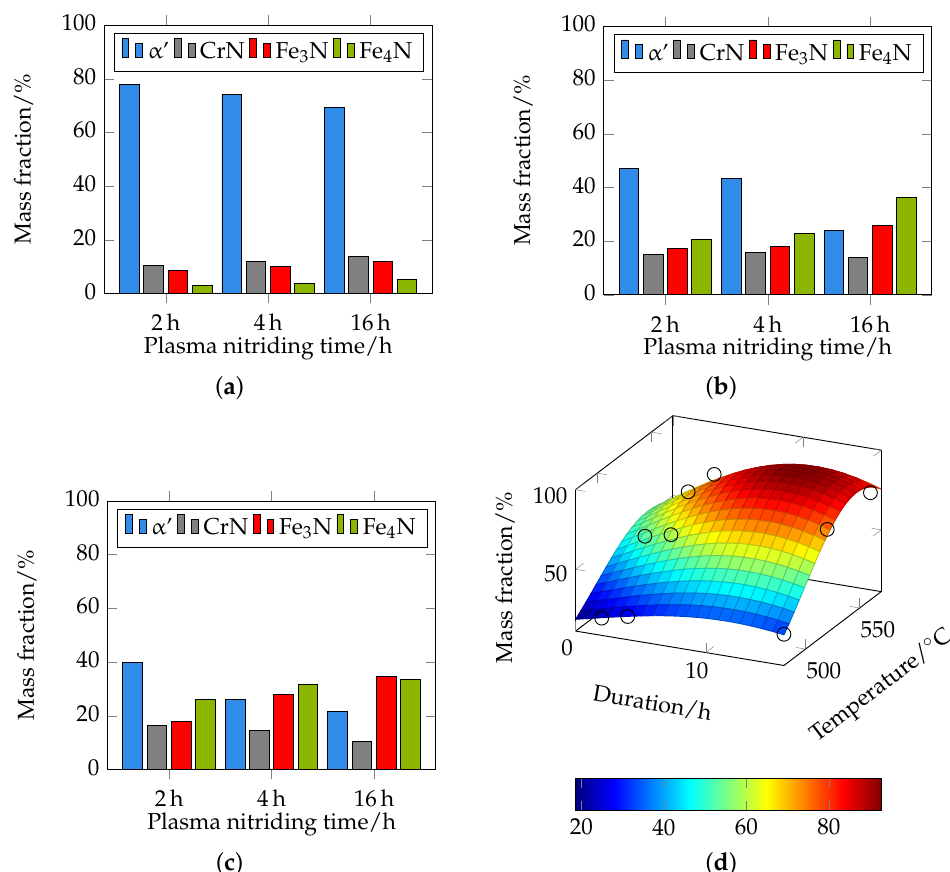
Figure 16. ( a – d ) show the mass fractions of the different phases of the high-alloy tool steel X153CrMoV12 plasma nitrided at different temperatures and durations determined by XRD. ( a ) Mass fractions of the different phases of the high-alloy tool steel X153CrMoV12 plasma nitrided at 480°C de- termined by XRD. ( b ) Mass fractions of the different phases of the high-alloy tool steel X153CrMoV12 plasma nitrided at 520°C determined by XRD. ( c ) Mass fractions of the different phases of the high- alloy tool steel X153CrMoV12 plasma nitrided at 560°C determined by XRD. ( d ) Approximated 3D plot of the sum of the mass fractions of the phases CrN, Fe 3 N, Fe 4 N of the high-alloy tool steel X153CrMoV12 plasma nitrided at different temperatures and durations determined by XRD.